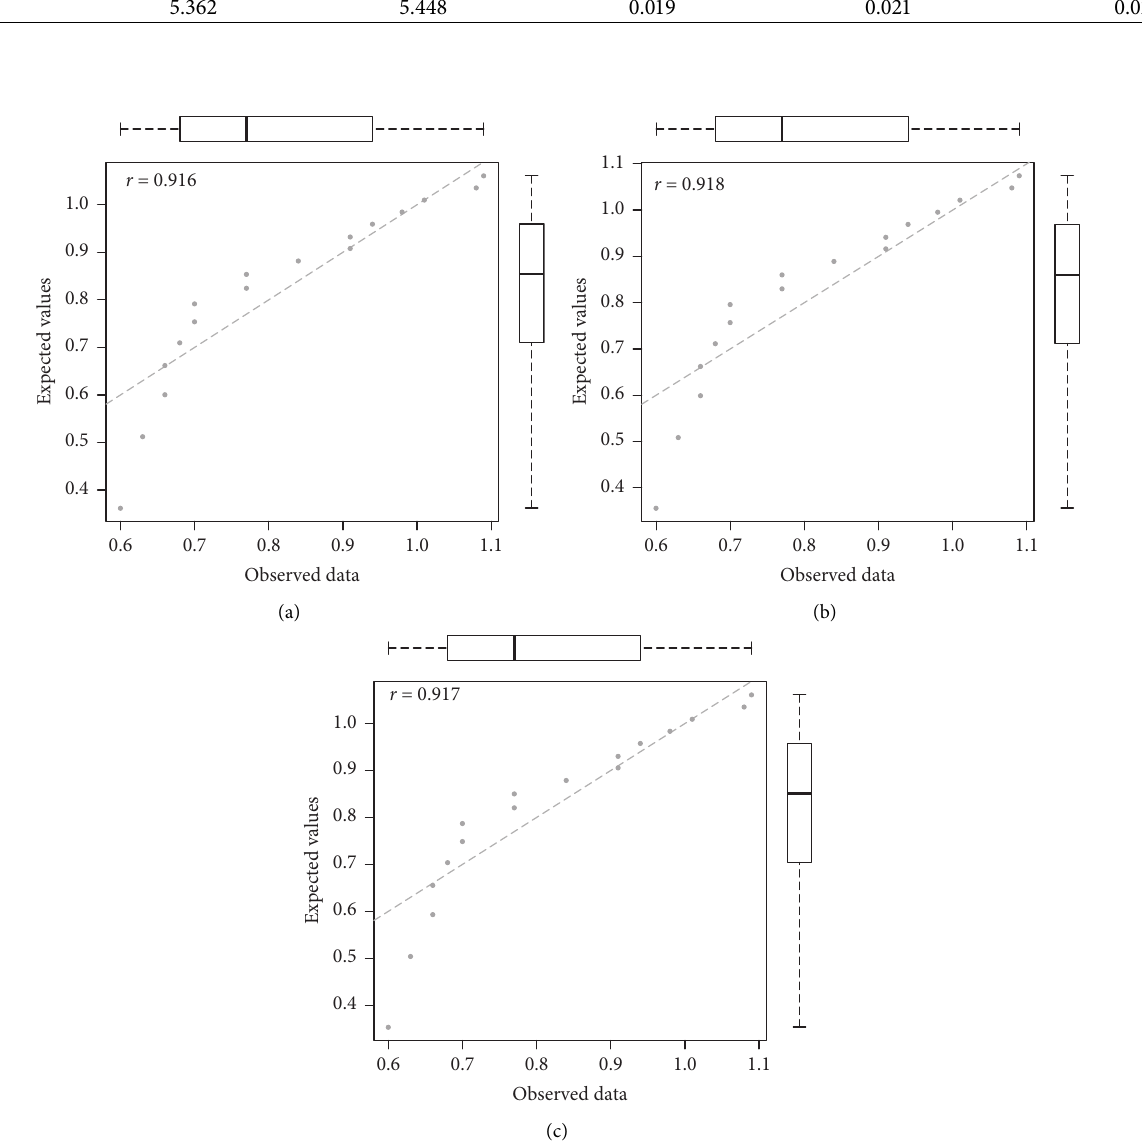
Figure 1: Box-scatter plots with (a) the MLEs 􏽢 λ and 􏽢 θ ( 􏽢 λ ) ; (b) the pivot-based estimators 􏽢 λ and 􏽢 θ wl ( 􏽢 λ wl )